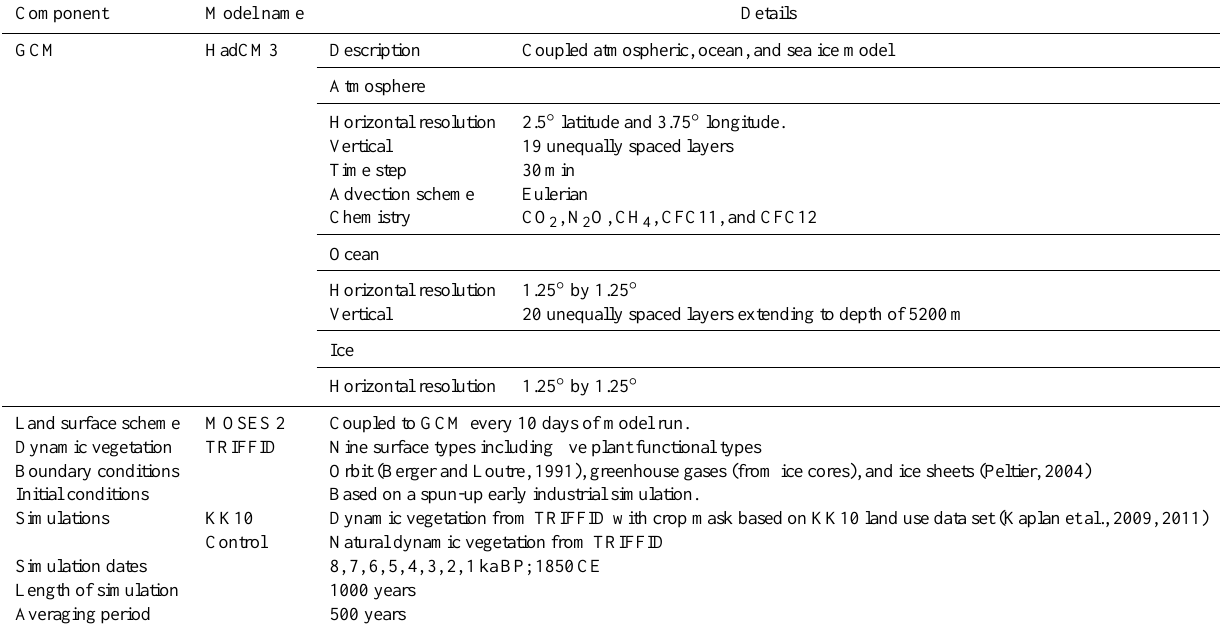
Table 1. Summary of the experimental